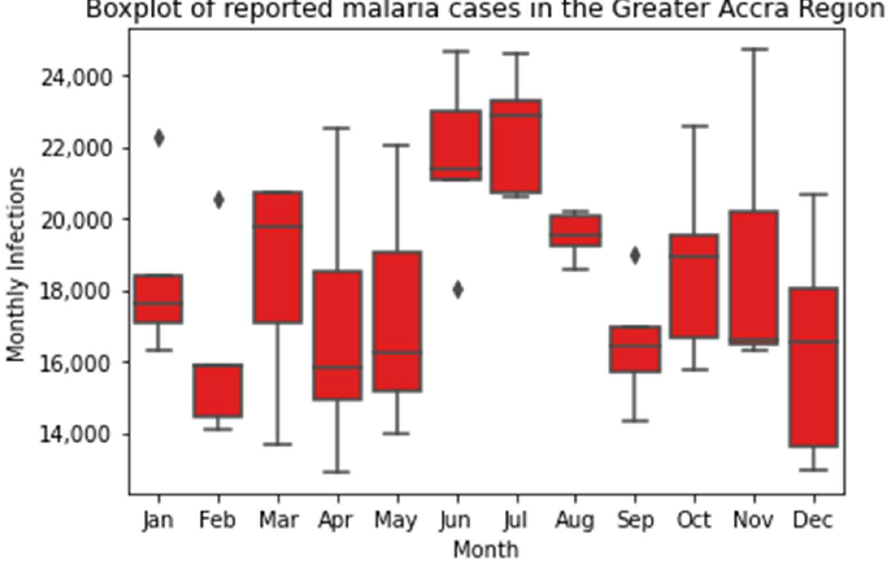
Figure 2. Boxplot of monthly reported malaria cases in the Greater Accra Region, 2015–2019. Dia- monds indicate outliers.